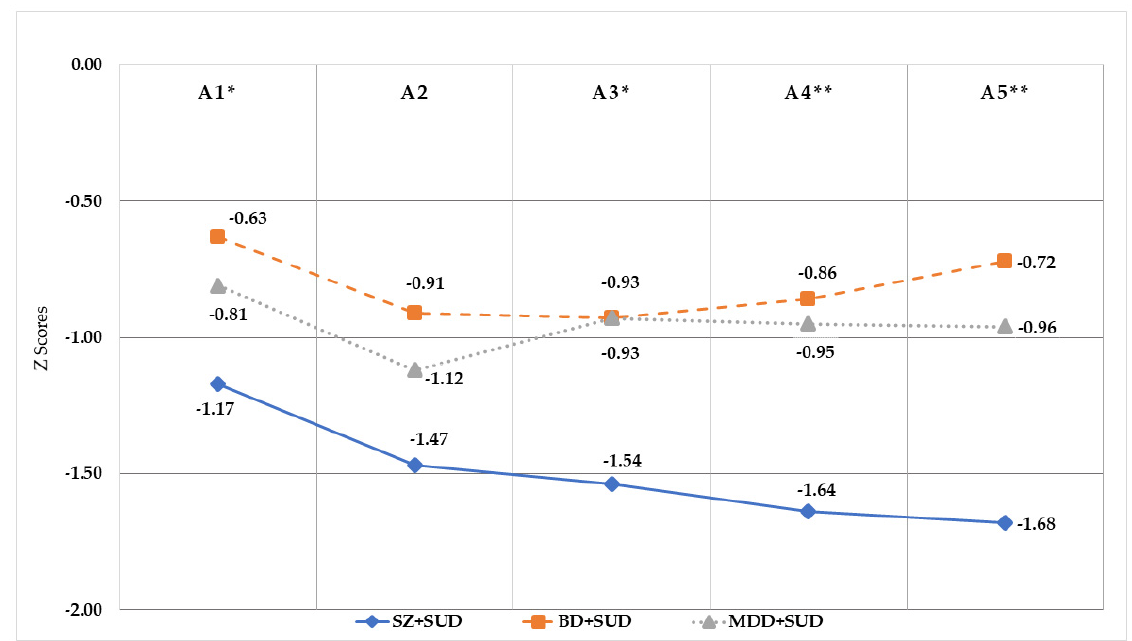
Figure 1. Learning curve in Z scores for the Rey Auditory Verbal Learning Test trials by groups. SZ + SUD: schizophrenia with comorbid substance use disorder; BD + SUD: bipolar disorder with comorbid substance use disorder; MDD + SUD: major depressive disorder and comorbid substance use disorder. * p < 0.05; ** p < 0.01.